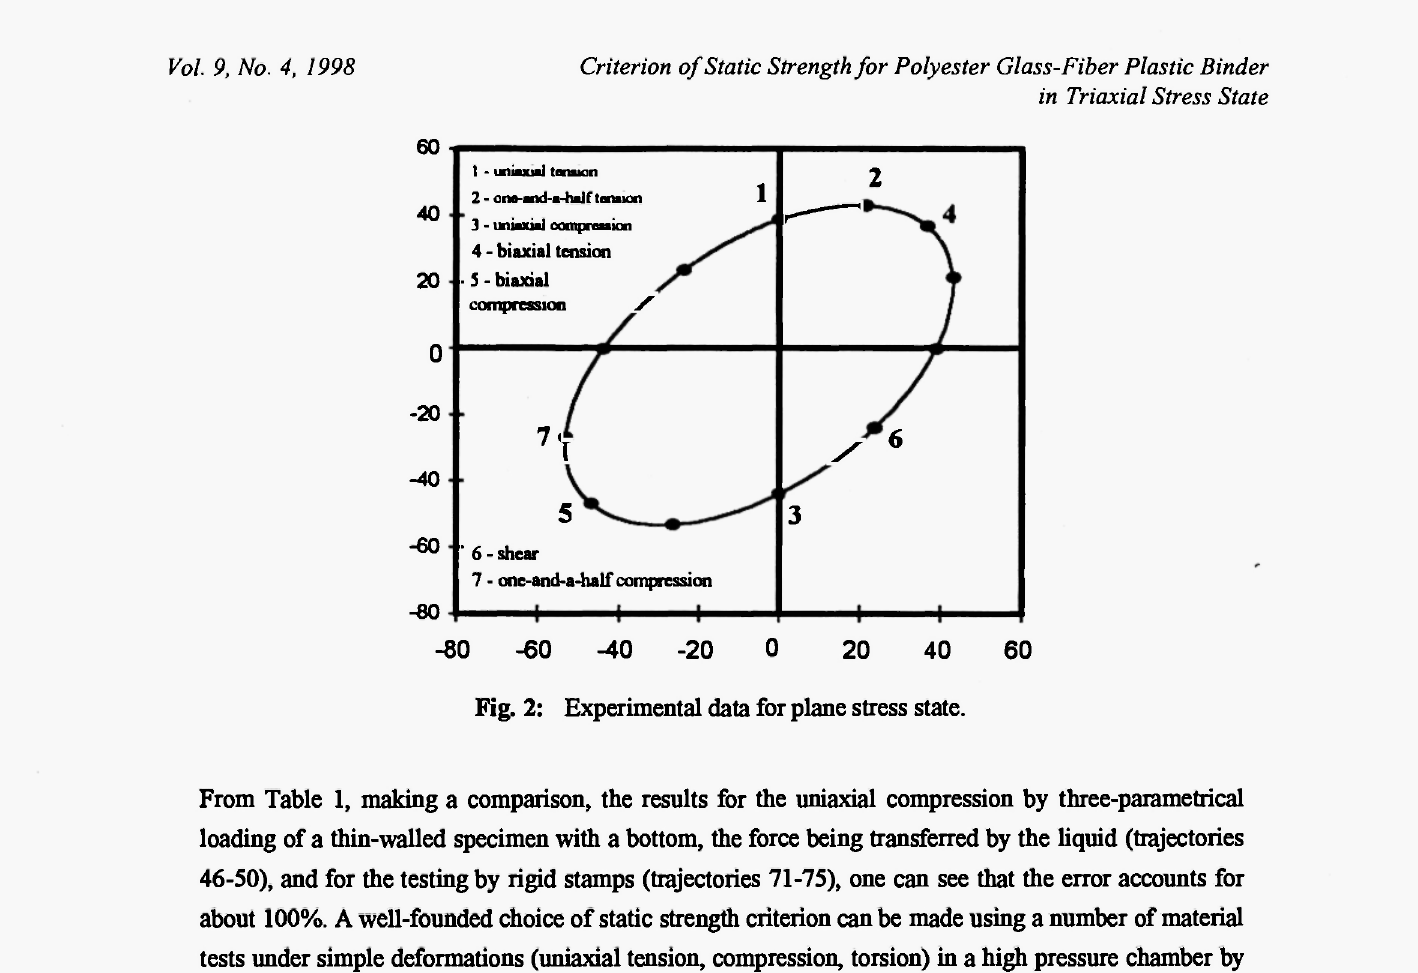
Fig. 2: Experimental data for plane stress